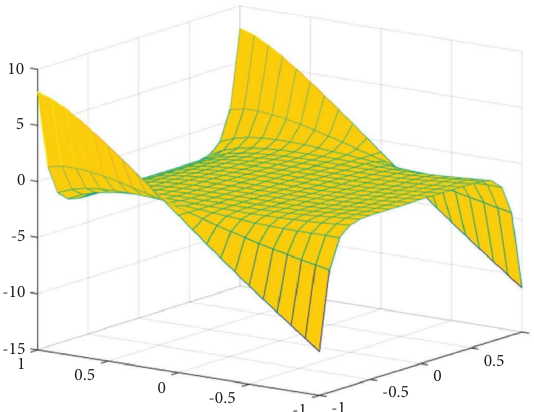
Figure 7: Te correlation of r and SO